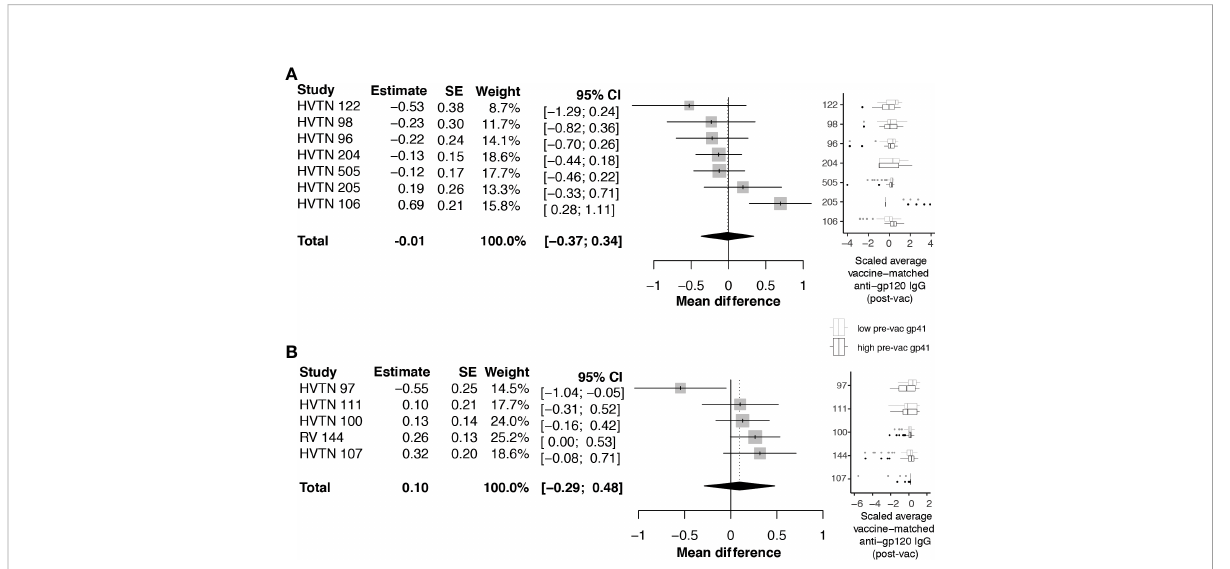
FIGURE 3 Difference in post-vaccine anti-gp120 IgG comparing trial participants with pre-vaccine anti-gp41 IgG level above vs. below the median level. Estimates and total pooled mean difference were estimated using random effects meta-analysis (see Methods for details). Models included either (A) protocols where vaccines included a gp41 immunogen, or (B) protocols where gp41 was not part of the study vaccine. Forest plots indicates estimated difference for each study, using size of the gray square to indicate study size, and horizontal line to indicate 95% CI. Boxplots to the left show distributions of scaled post-vaccine anti-gp120 averaged across vaccine matched antigens, where the box (IQR) and whiskers (+/- 1.5 IQR) show distribution of response among participants split above (black) and below (gray) the median pre-vaccine anti-gp41 response measured in each